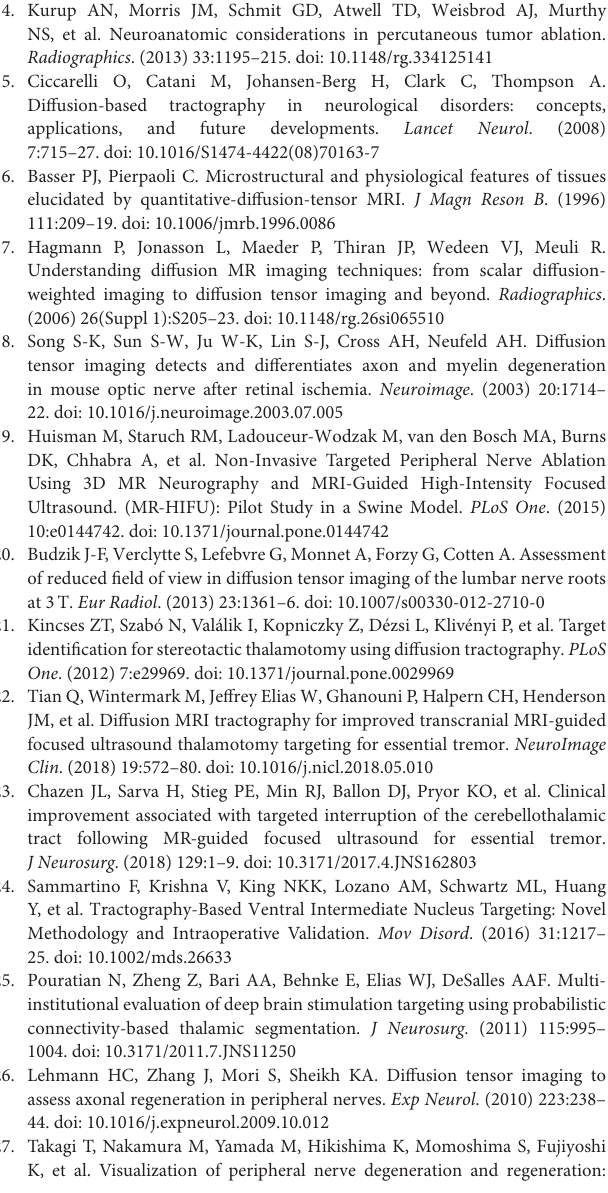
Supplementary Figure 1 | CSD tractography of the sciatic nerve segmented by fiber bundle vertebral origin and distal termination (individual tracts separated by color). Full reconstructed tracts visible from (A) axial, (B) sagittal, and (C) coronal view. (D) Axial views showing only tract segments within the visible slice centered on the MRgFUS lesion. (E) Lesion zones I (red) and II (blue) are highlighted. CSD, constrained spherical deconvolution; MRgFUS, magnetic resonance-guided focused